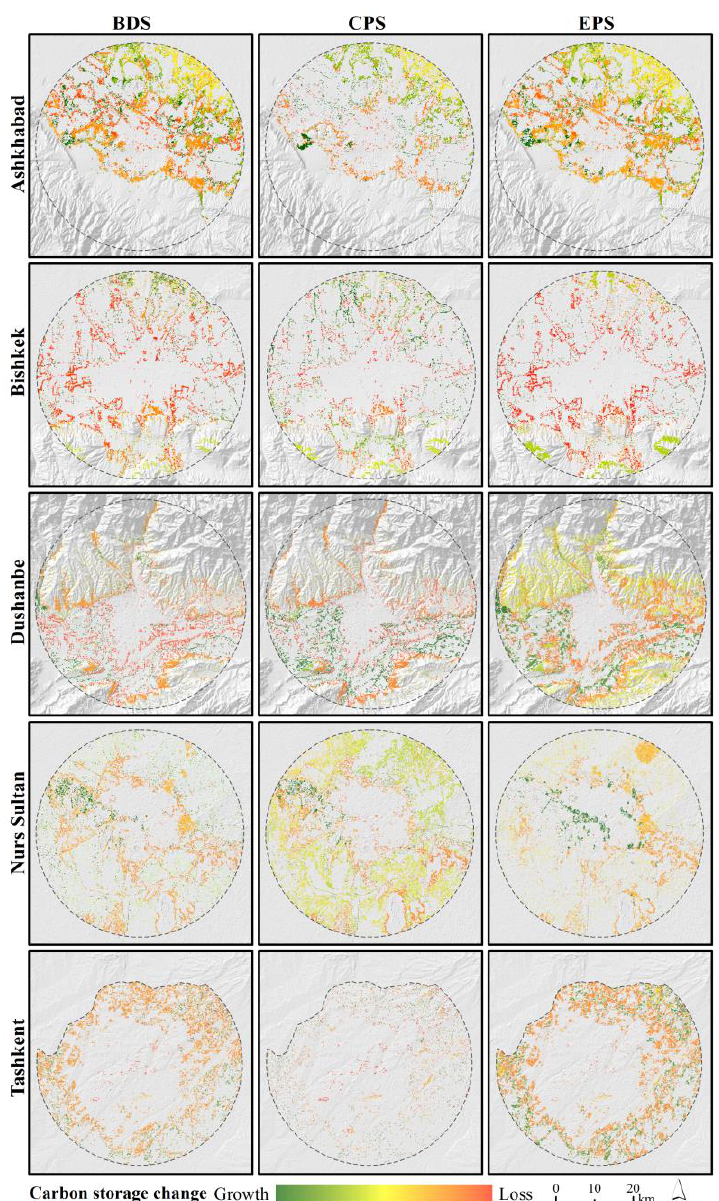
Figure 6. The distribution of carbon storage changes under three scenarios. Note: unchanged carbon storage in the corresponding land type is set as colorless.